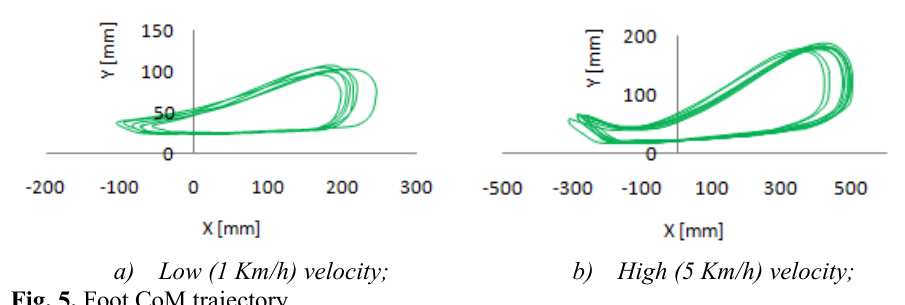
Fig. 5. Foot CoM trajectory.